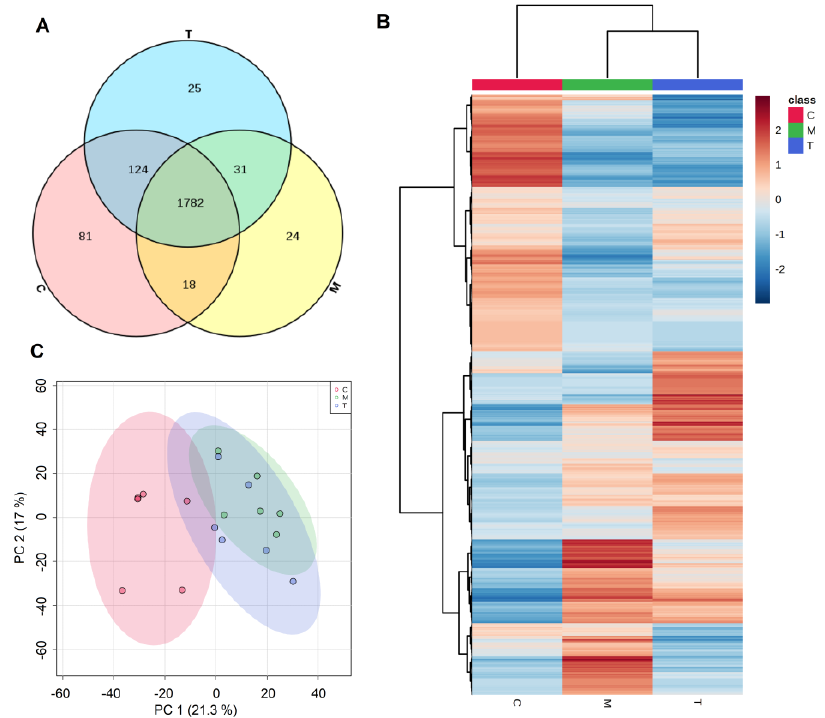
Figure 2. ( A ) Venn diagram analysis ( B ) hierarchical clustering; ( C ) Principal component analysis (PCA) score plot; C, colostrum (3 – 6 days); T, transitional milk (7 – 14 days); M, mature milk (15 – 29 days). (15–29